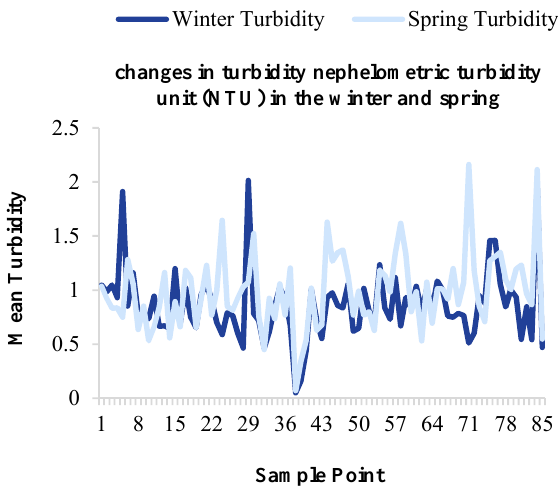
Figure 3. Residual chlorine fluctuation in winter